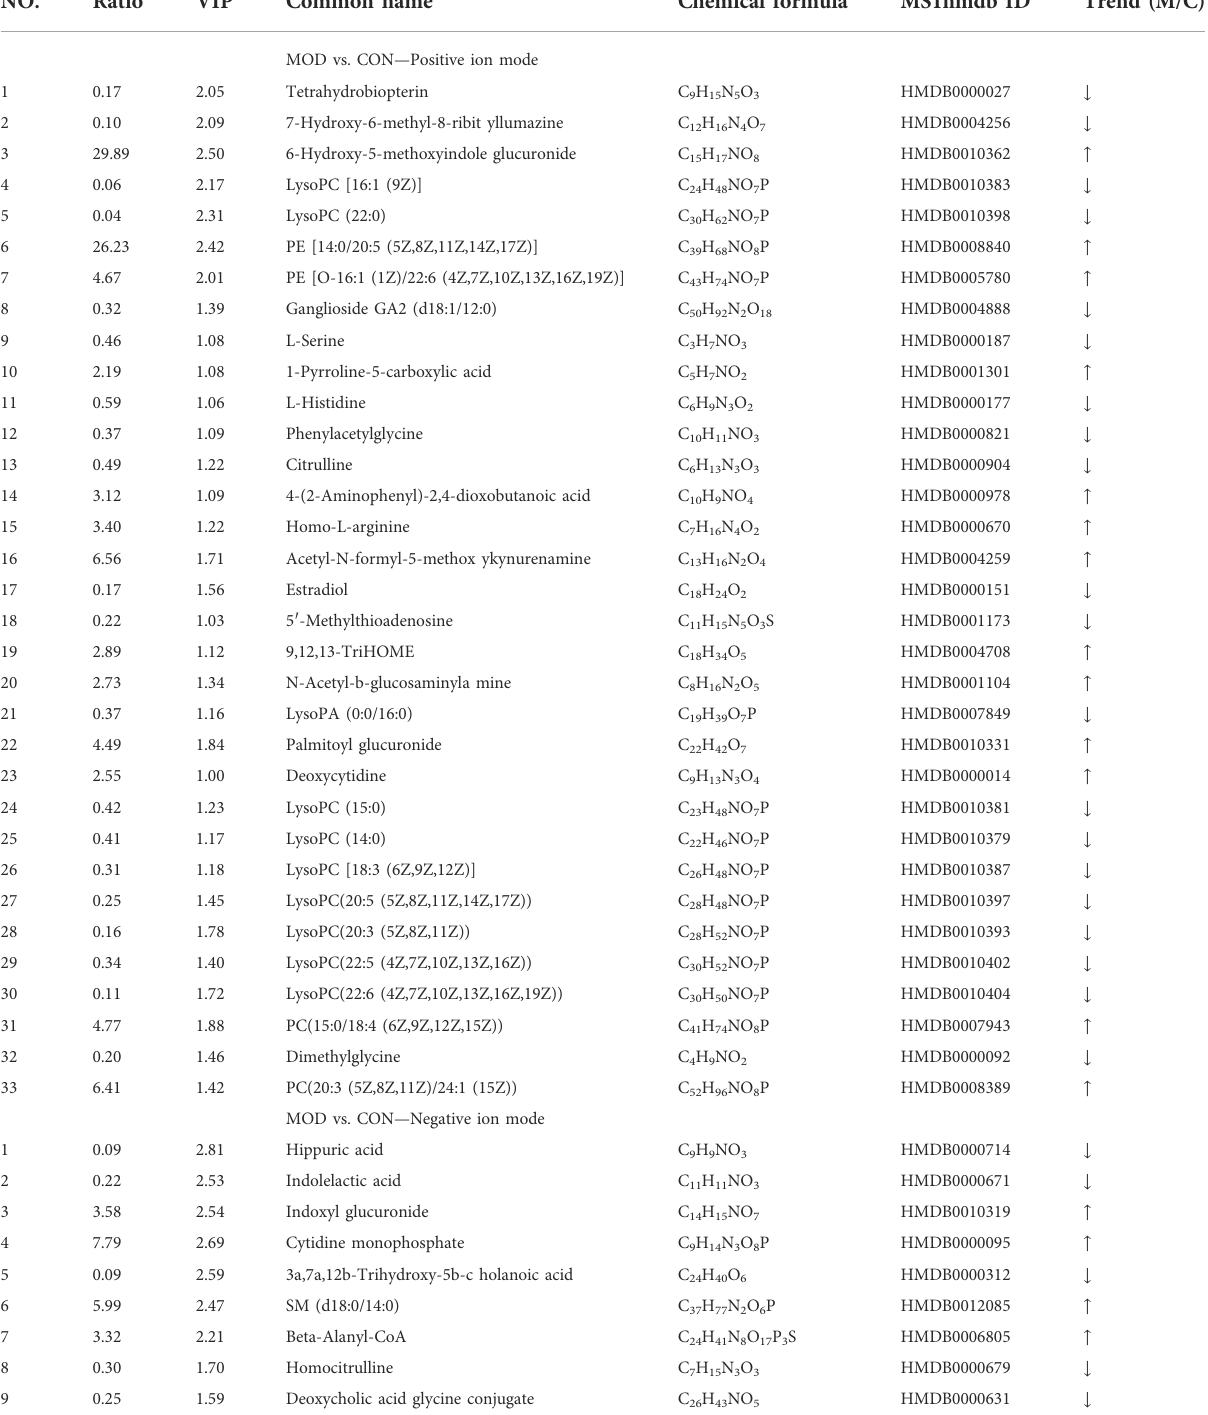
TABLE 1 Differential metabolites and their identi fi cation results of serum from the control and model groups. NO. Ratio VIP Common name MS1hmdb ID Trend